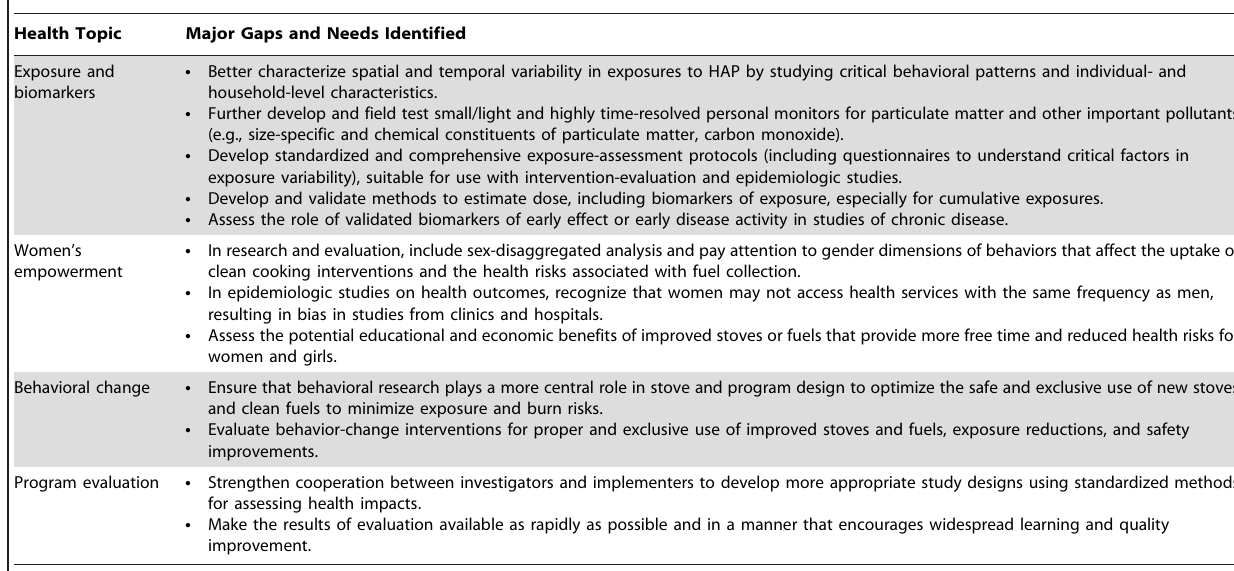
Table 2. Summary of major gaps and research needs for cross-cutting